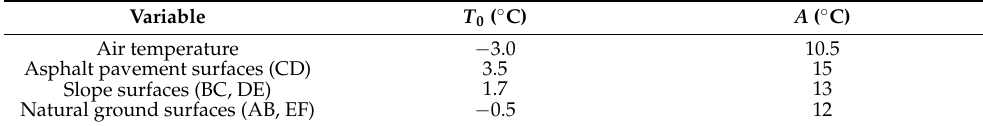
Table 4. Temperature parameters of the upper surface